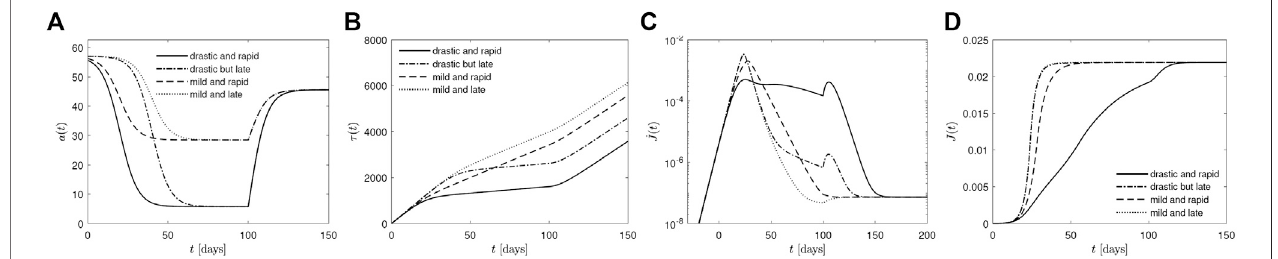
FIGURE 7 | Same as Figure 4 but with incomplete lifting ( η (cid:2) 0 . 8) hundred days after breakout ( t s (cid:2) 100 days). (A) infection rate a ( t ) , (B) reduced time τ ( t ) , (C) daily rate of new infections _ J ( t ) , (D) cumulative fraction J ( t ) of infected persons. In each panel we consider four basic types of reductions: 1) drastic (small q (cid:2) 0 . 1) and rapid ( t a (cid:2) 20), 2) drastic (small q (cid:2) 0 . 1) and late ( t a (cid:2) 40), 3) mild ( q (cid:2) 0 . 5) and rapid ( t a (cid:2) 20), and 4) mild ( q (cid:2) 0 . 5) and late ( t a (cid:2) 40). Remaining parameters due to Germany: t b (cid:2) 11 days, a 0 (cid:2) 57 days − 1 , and k (cid:2) 0 . 989.